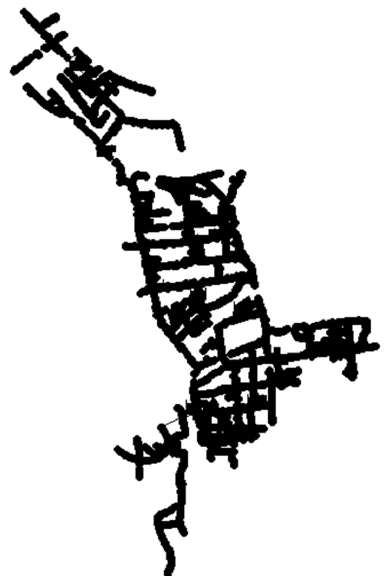
Figure 8. SWMM model used for evaluation of storage capacity. Table 3. Parameters of the I/I model for inflow in each sewage